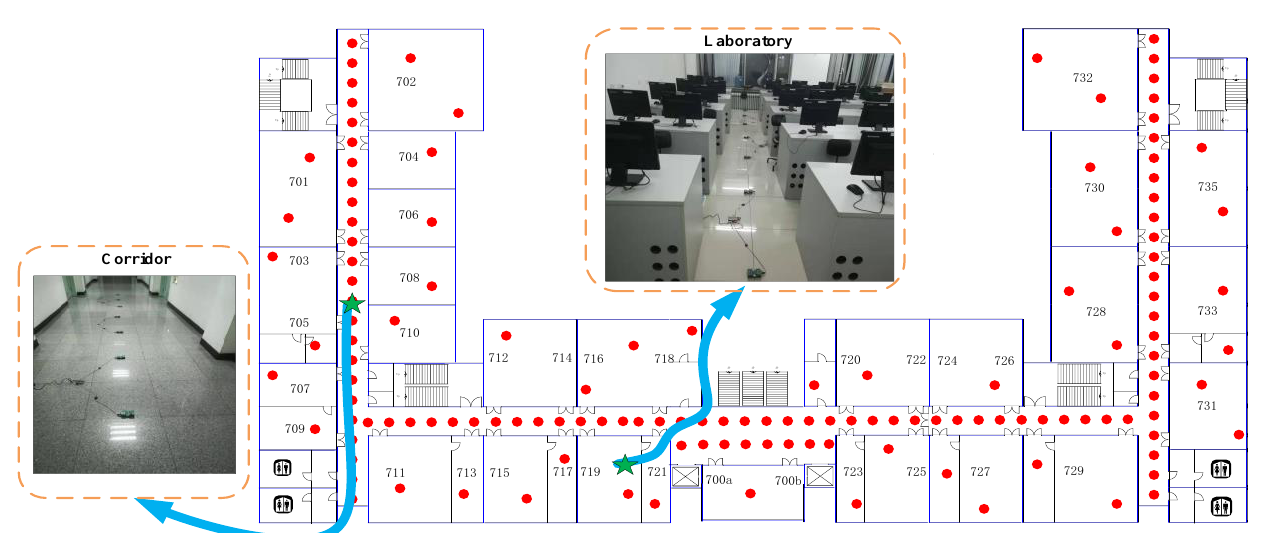
Figure 2. The collection process of magnetic fingerprint